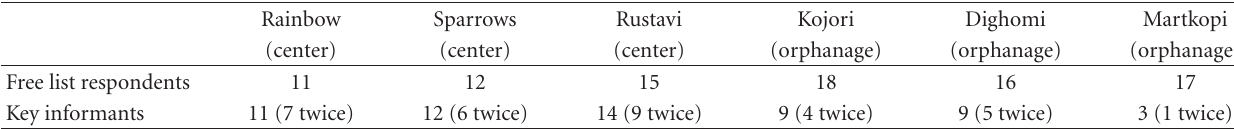
Table 4: Numbers of study 2 respondents, across